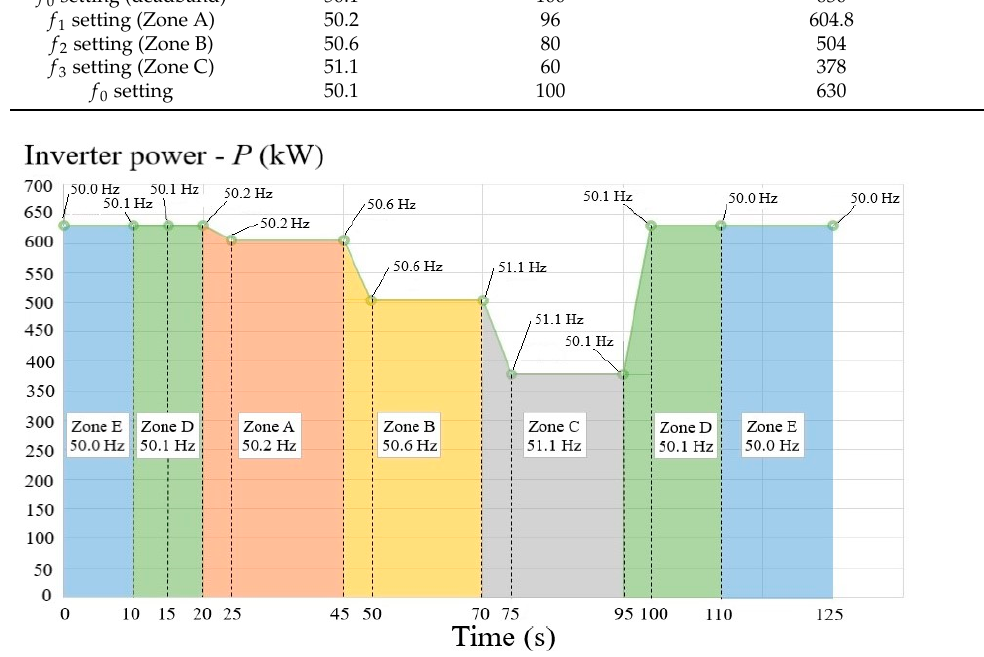
Figure 2. Diagram of PVP power limitation under the frequency rise ( P in = P rated ). Zone E (Figure 2) corresponds to the deadband, i.e., PVP power output is not limited. Zone D is the frequency value going beyond the deadband up to f 1 = 50.2 Hz (a 5 s waiting until the power limitation starts); PVP power restoration to P rated without waiting at a fre- quency decrease to f 0 = 50.1 Hz. Table 2. The PVP primary power for the frequency decline below 49.9 Hz.